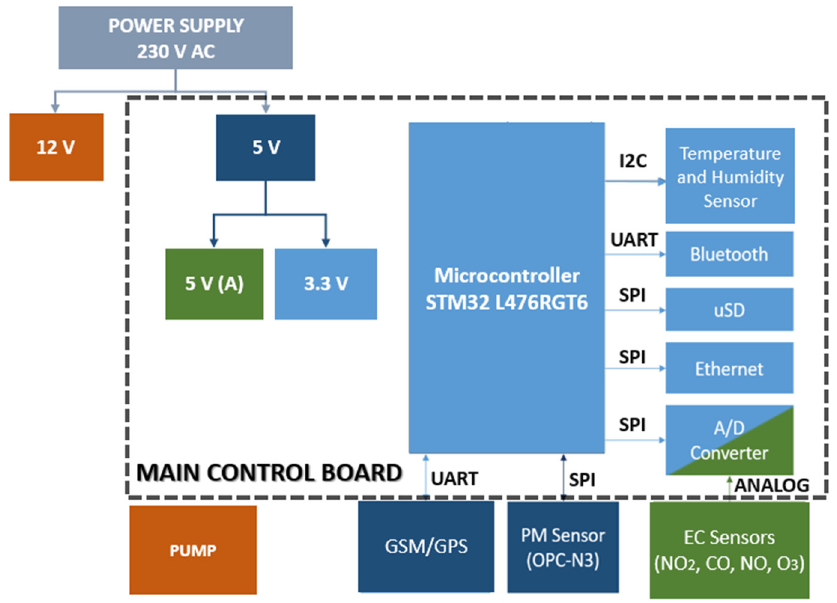
Figure 1. General diagram of the electronic design.